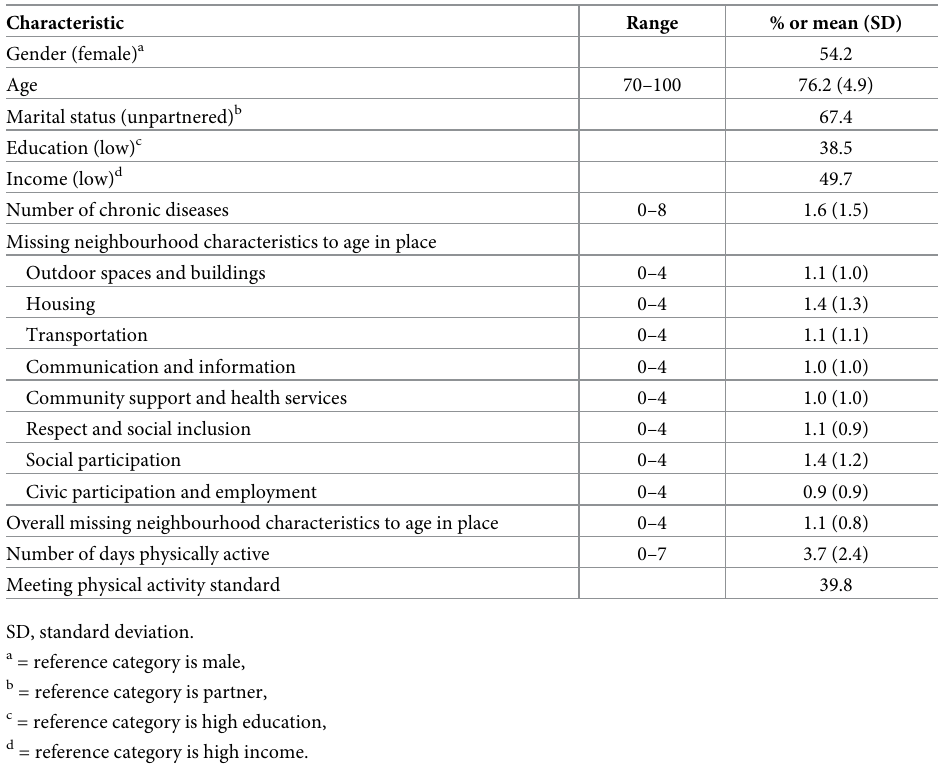
Table 1. Descriptive statistics for the study population ( n =